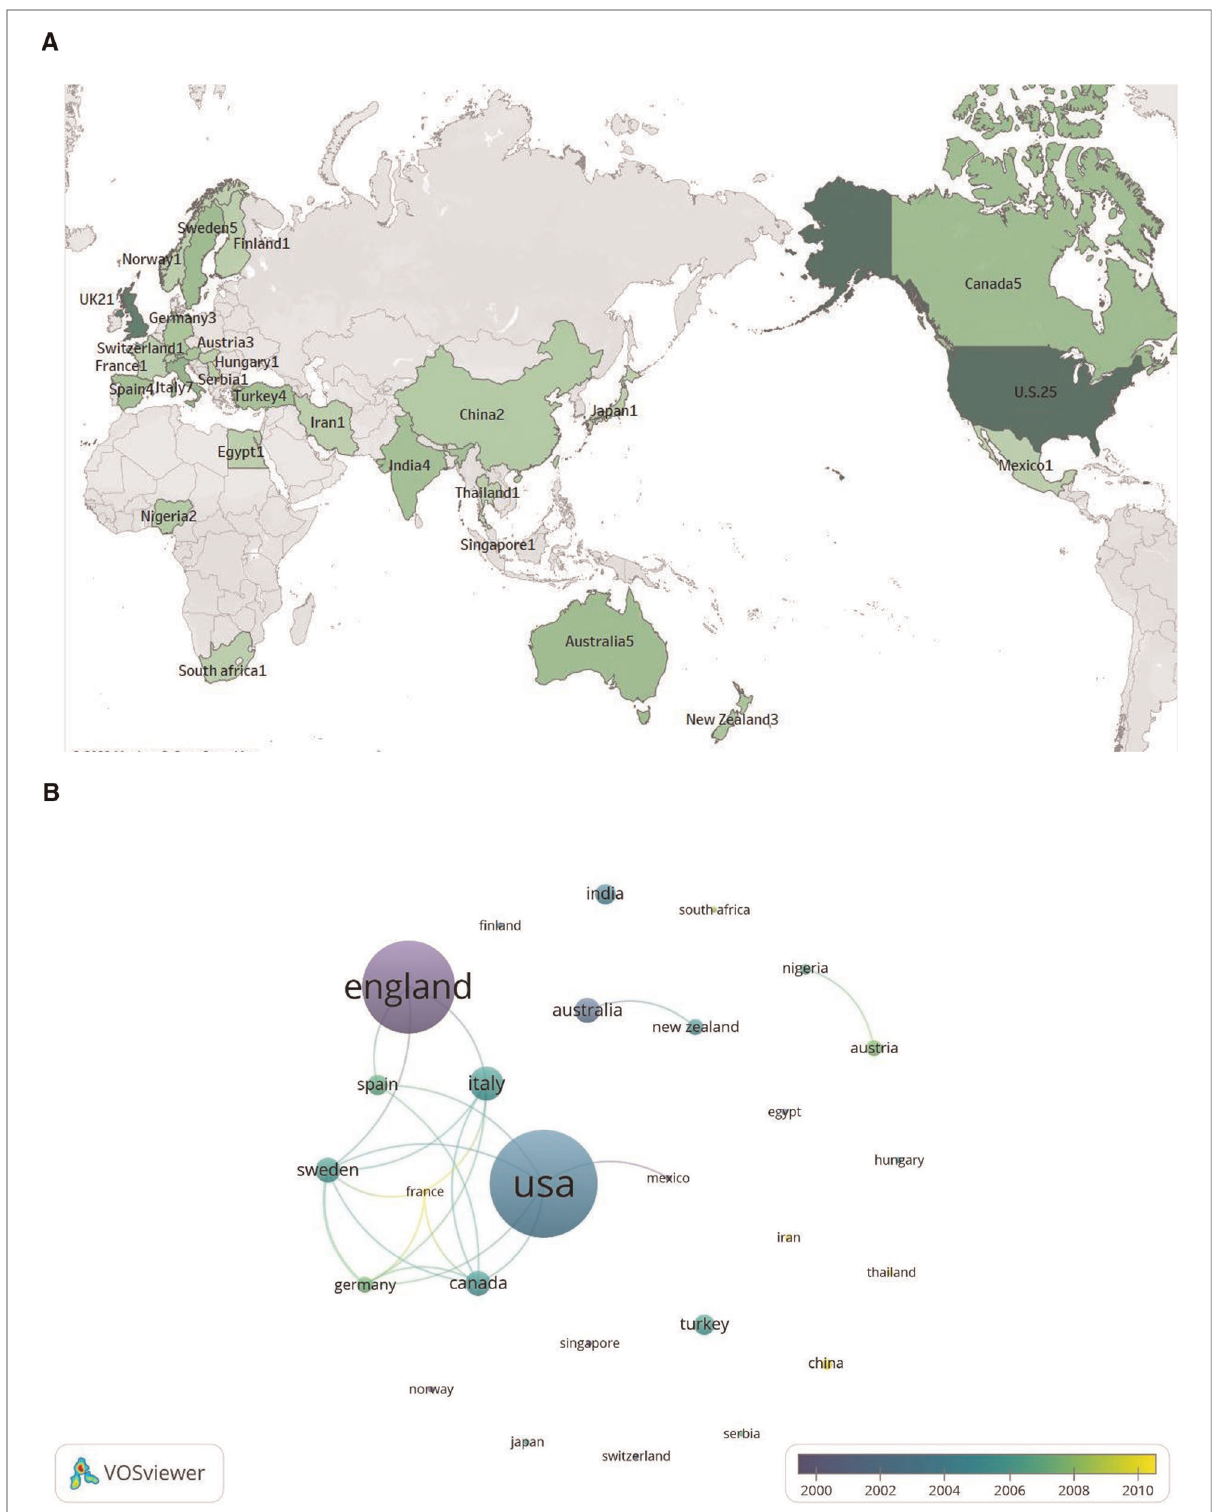
FIGURE 4 Countries of publication of the top 100 most-cited articles. ( A ) Geographical visualization of national publications, ( B ) Countries ’ cooperation coexistence